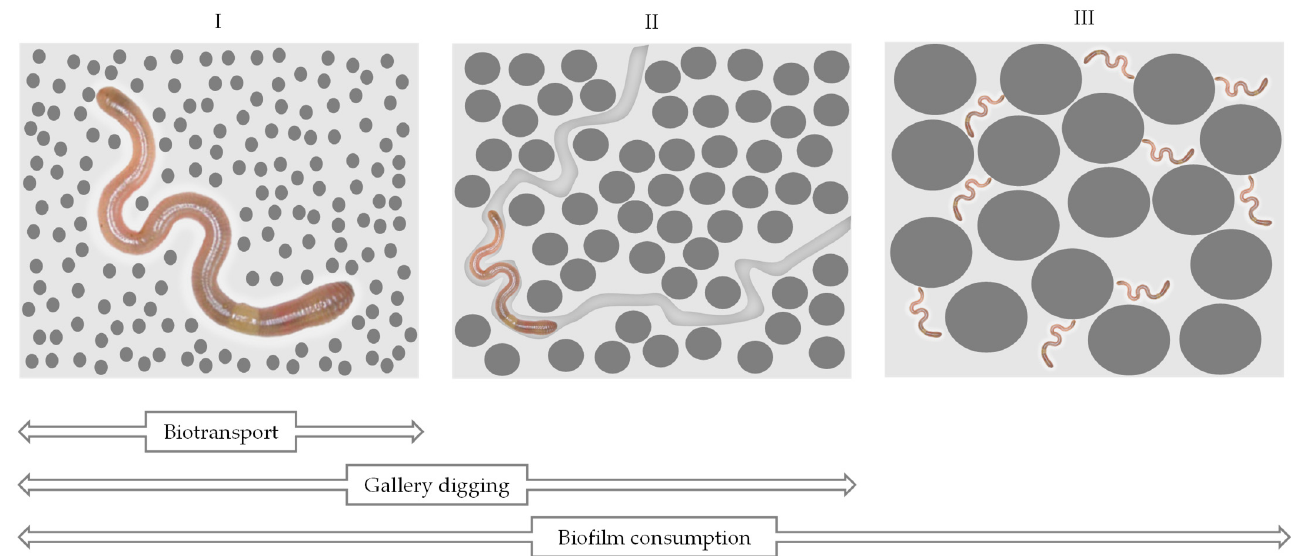
Figure 2. Three types of bioturbations controlled by the sizes balance between sediment/soil particles and engineering organisms. The arrows show that gallery digging and biofilm consumption are also possible with smaller granulometry.